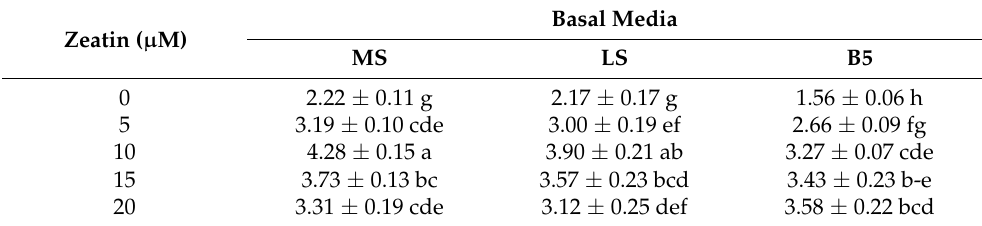
Table 4. Interaction effects of different basal media and zeatin concentrations on the number of shoots per explant of ‘Bentong’ ginger after six weeks of